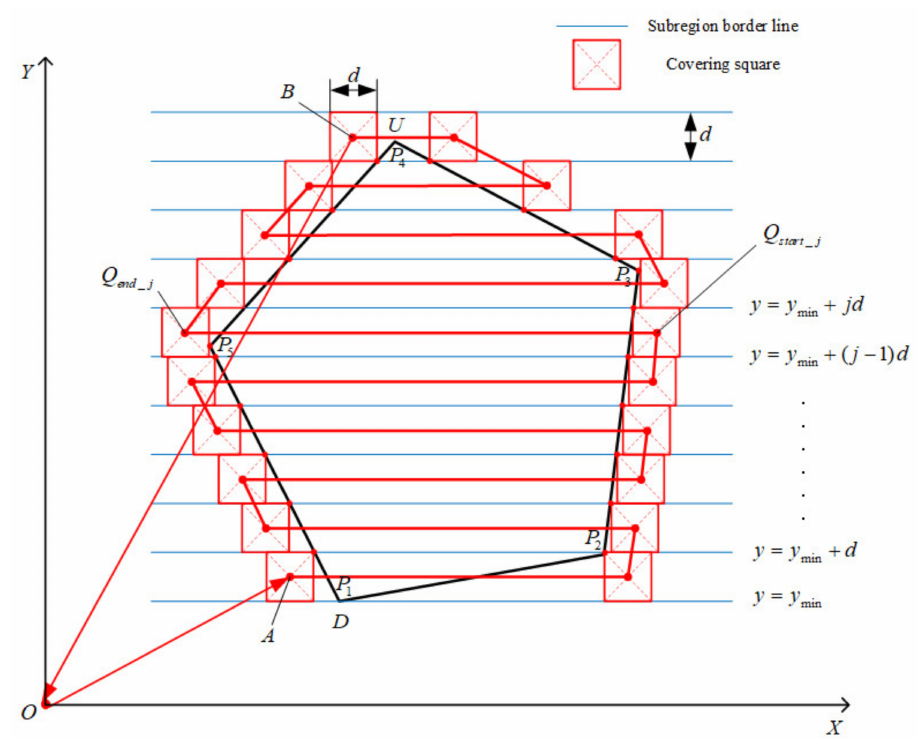
Figure 3. The route generated using the method based on subregion. Point A is the first starting point of the route. Point B is the last ending point of the route. Point O is the takeoff point. Point D is the point that has the minimum Y -coordinate value among the vertices of the operation region. Point U is the point that has the maximum Y -coordinate value among the vertices of the operation